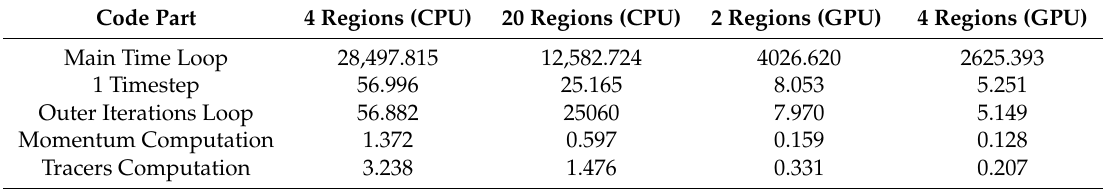
Table 2. Computation time in seconds for different procedures of the code (only ClusterUy